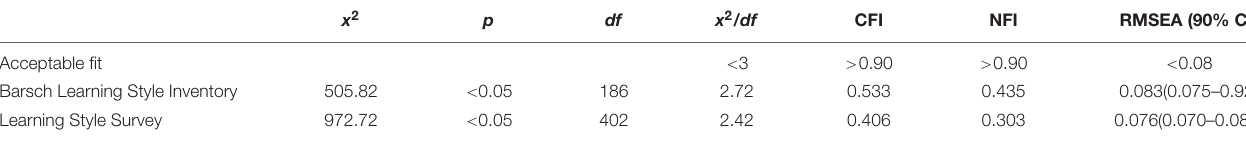
TABLE 2 | Goodness-of-fit indices for the psychometric measurement model applied to Barsch Learning Style Inventory and learning style